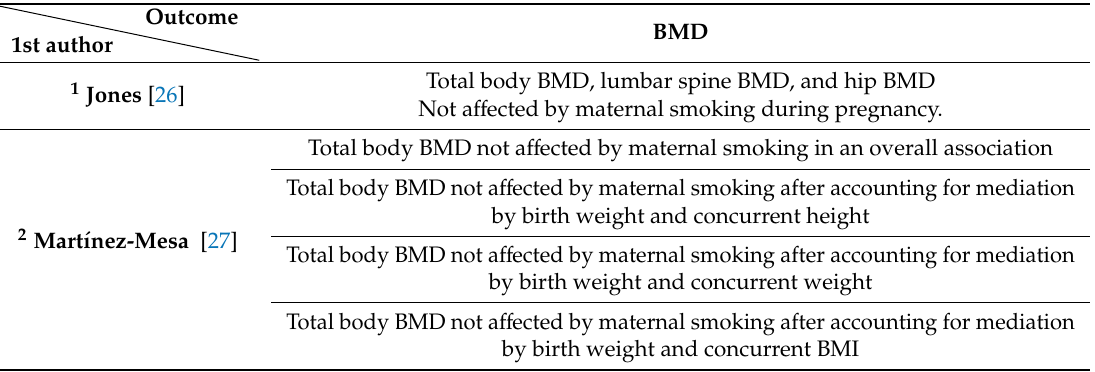
Table 6. Association between maternal cigarette smoking during pregnancy and o ff spring bone mineral density in